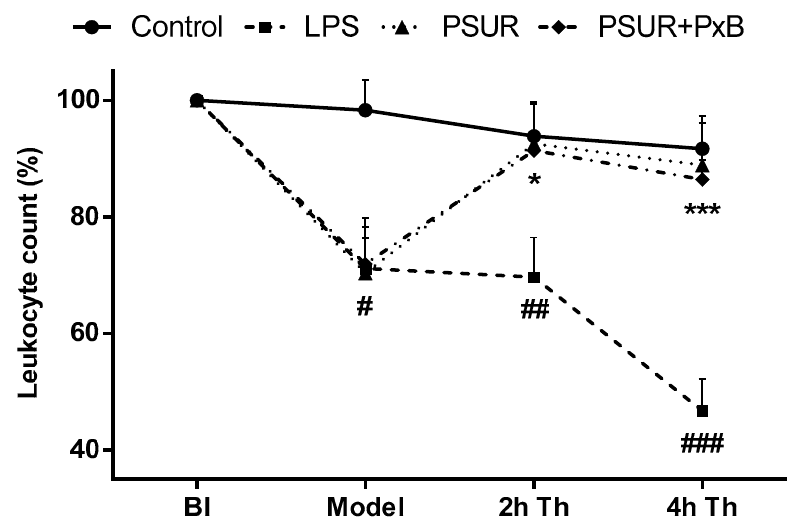
Figure 9. Total leukocyte count in arterial blood before instillation (BI) of saline (Control) or lipopolysaccharide (LPS), 1 h after instillation (Model) and therapy (Th) administration during 4 h of experiment, expressed as a percentage (%). Control vs. LPS # p < 0.05, ## p < 0.01, ### p < 0.001, PSUR vs. LPS, PSUR + PxB vs. LPS * p < 0.05, *** p < 0.001. Table 2. Median fold change (FC) and p -values for SP gene expression after treatment with PSUR alone or in combination with